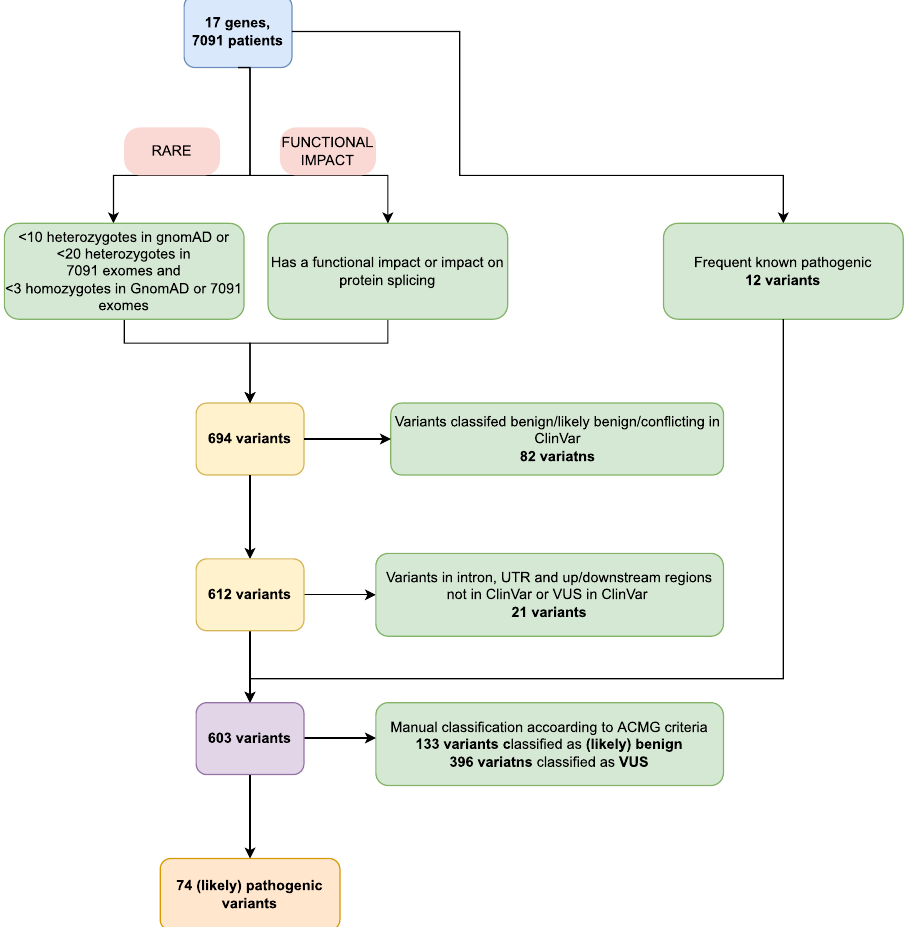
Figure 1. Variant filtering and classification process. Amidst 694 rare and functional or known pathogenic variants found in our population, 107 variants were classified as benign (B), likely benign (LB), or a variant of uncertain significance (VUS) during the filtering process (filtered variants). Firstly, 82 variants were classified as B, LB, or conflicting between B, BL, and VUS based on their ClinVar classification. Next, variants in noncoding regions and synonymous variants that were not present in ClinVar or were classified as VUS in ClinVar were assigned VUS status (21 variants). We added 12 variants to the classification group since they are known pathogenic variants, frequent in control populations and cancer patients. The resulting 603 variants were classified manually according to the American College of Medical Genetics and Genomics and the Association for Molecular Pathology (ACMG) standards and guidelines for the interpretation of sequence variants (ACMG guidelines). We classified 603 variants into five categories: pathogenic (P), likely pathogenic (LP), variant of uncertain significance, and likely benign or benign. Six variants were classified as benign, 127 were likely benign, 396 were VUS, of which ten were conflicting between B/LB and P/LP and there was not enough data to classify the remaining 381 variants into either B/LB or P/LP categories. Lastly, 14 variants were likely pathogenic and 60 were classified as